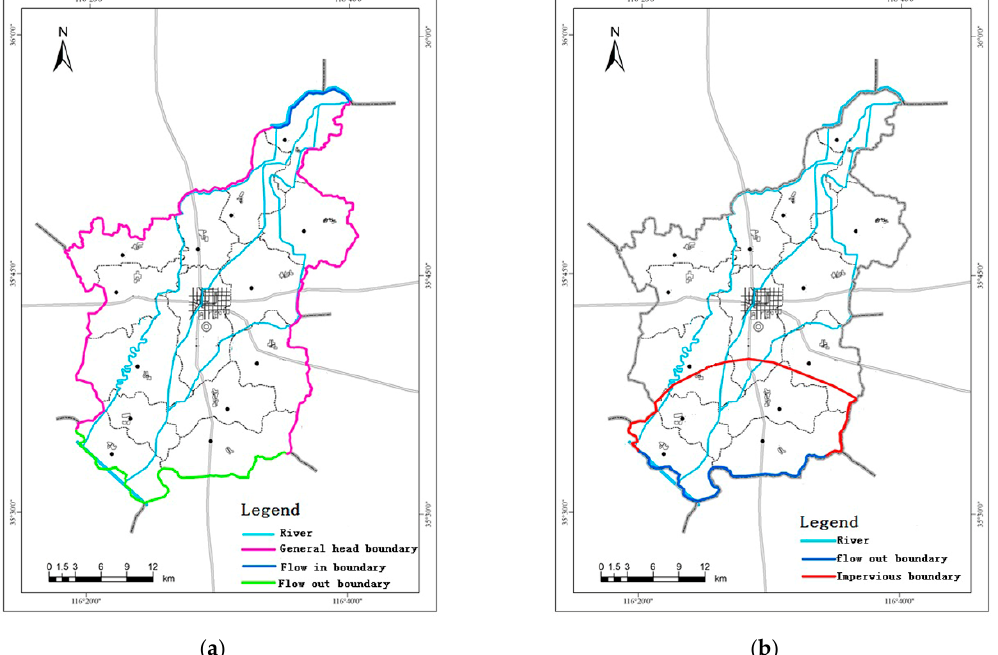
Figure 4. ( a ) The first aquifer range and boundary conditions. ( b ) The second aquifer range and boundary conditions.